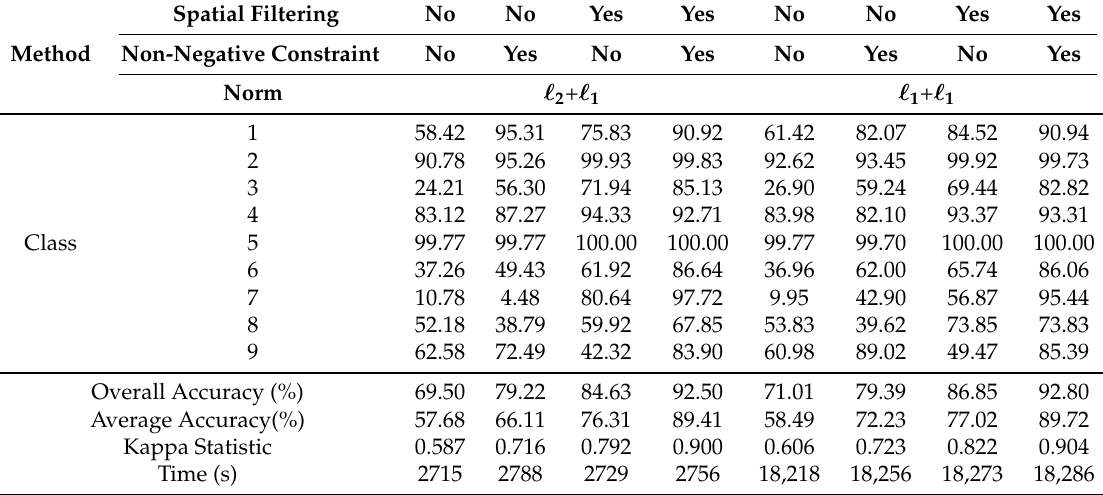
Table 5. Overall Accuracy, Average Accuracy, Kappa Statistic and Time of the Pavia University data set when using pixel-wise